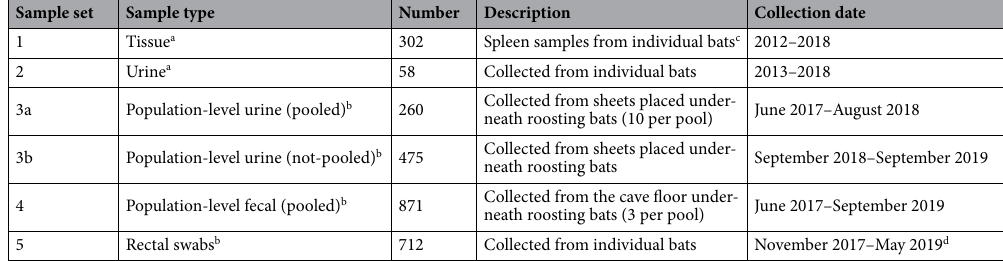
Table 1. Sample selection for assessing the diversity and excretion dynamics of henipa- and related viruses in Egyptian rousette bats. a Opportunistically collected. b Longitudinal monthly collection. c Kidney, liver, lung and intestinal tissue tested for spleen-positive individuals. d Collection of rectal swabs was not performed